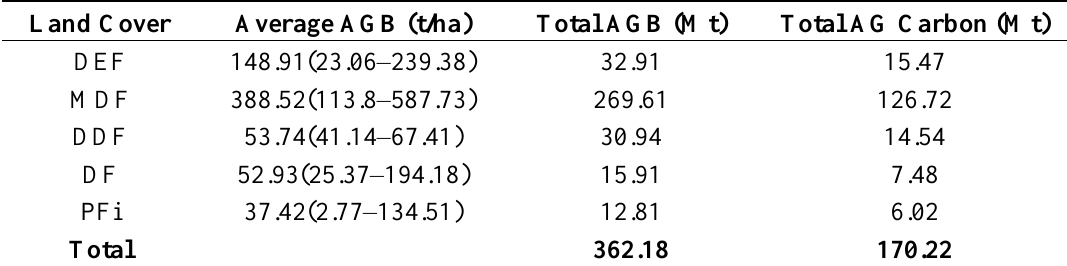
Table 11. Total AGB and carbon stock estimation for each land-cover type.